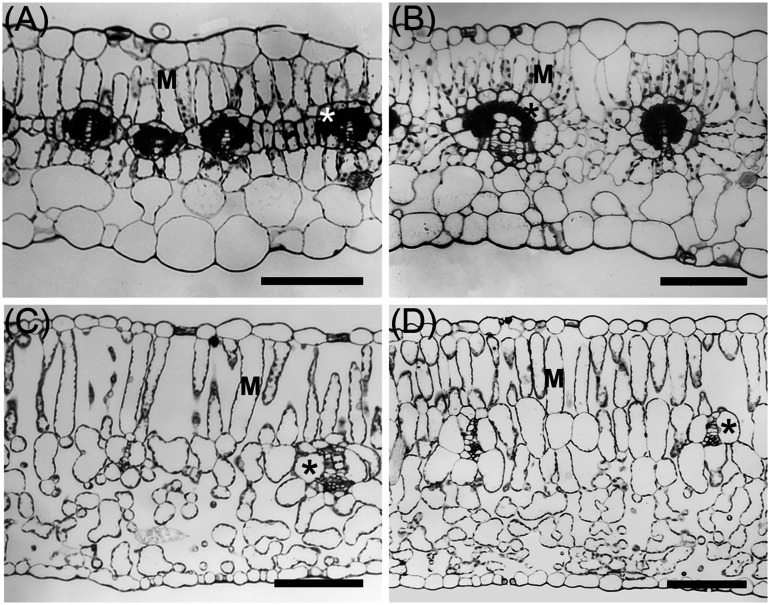
Light microscope images of leaves from C3 and C4 species of Nyctaginaceae, tribe Nyctagineae. (A)
Allionia incarnata, (B)
Boerhavia coccinea, (C)
Commicarpus scandens, (D)
Nyctaginia capitata. M, mesophyll cells; *Asterisks mark bundle sheath cells. Scale bars = 100 μm.